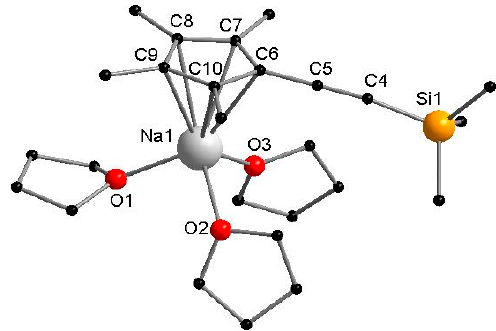
Figure 1. Molecular structure of 1 in the solid state. Hydrogen atoms are omitted for clarity. Selected